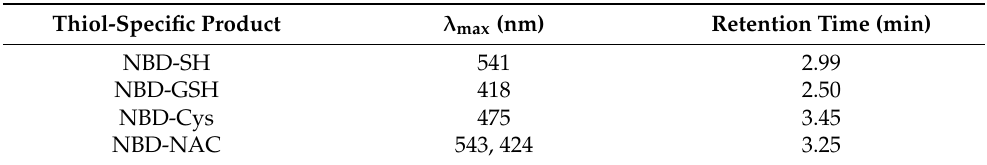
reaction of NBD-O-CmCH 2 OH with H 2 S, GSH, L-Cys, and NAC.